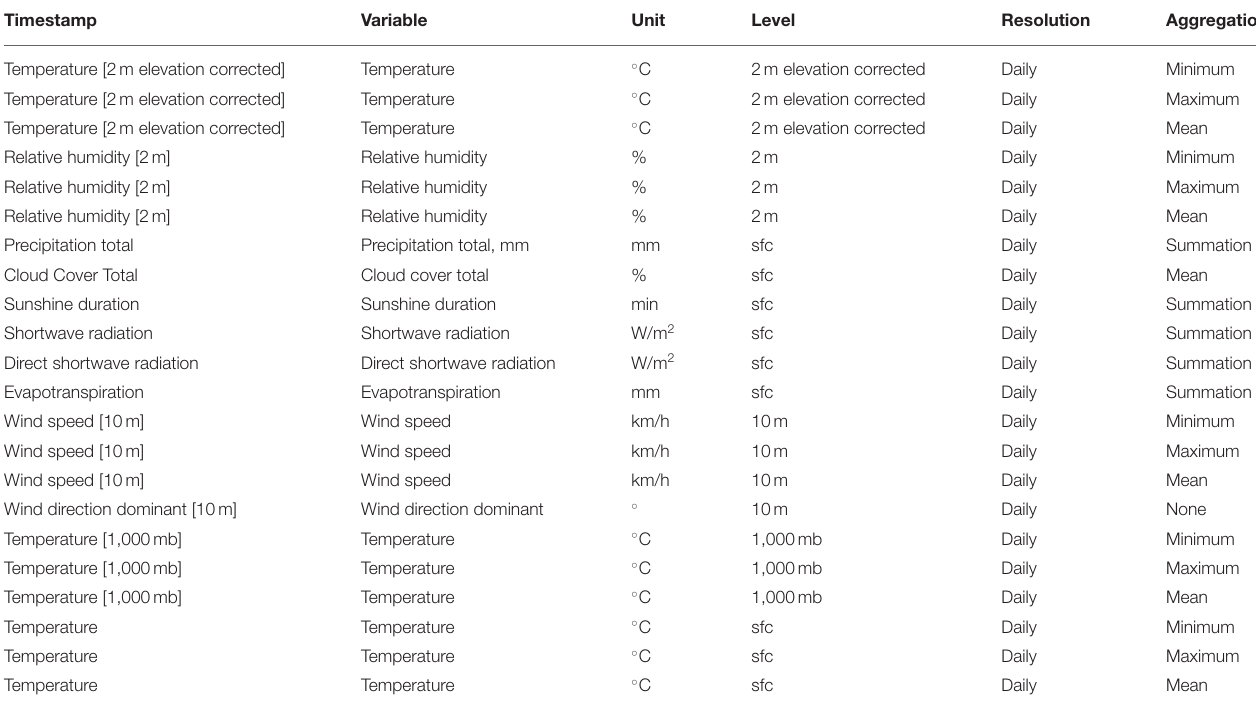
TABLE 1 | The temperature, wind speed, cloud cover, precipitation rate, and other weather parameters of Dubai City for the duration of patient recruitment using history + (https://www.meteoblue.com/en/historyplus). Timestamp Variable Unit Level